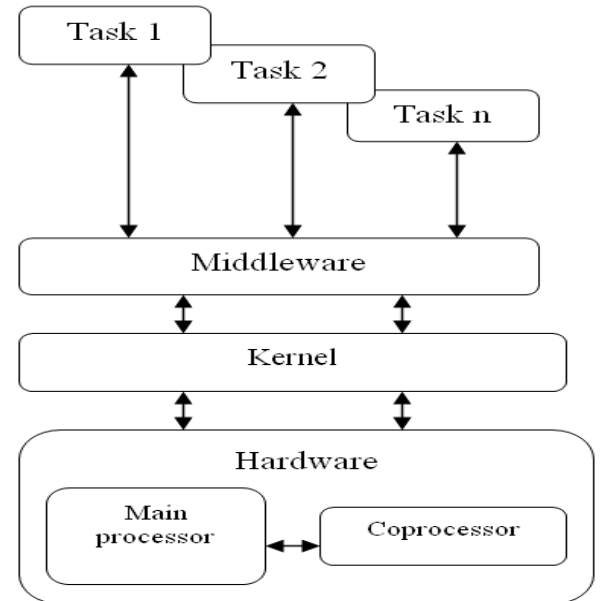
Figure 2. Logical architecture for